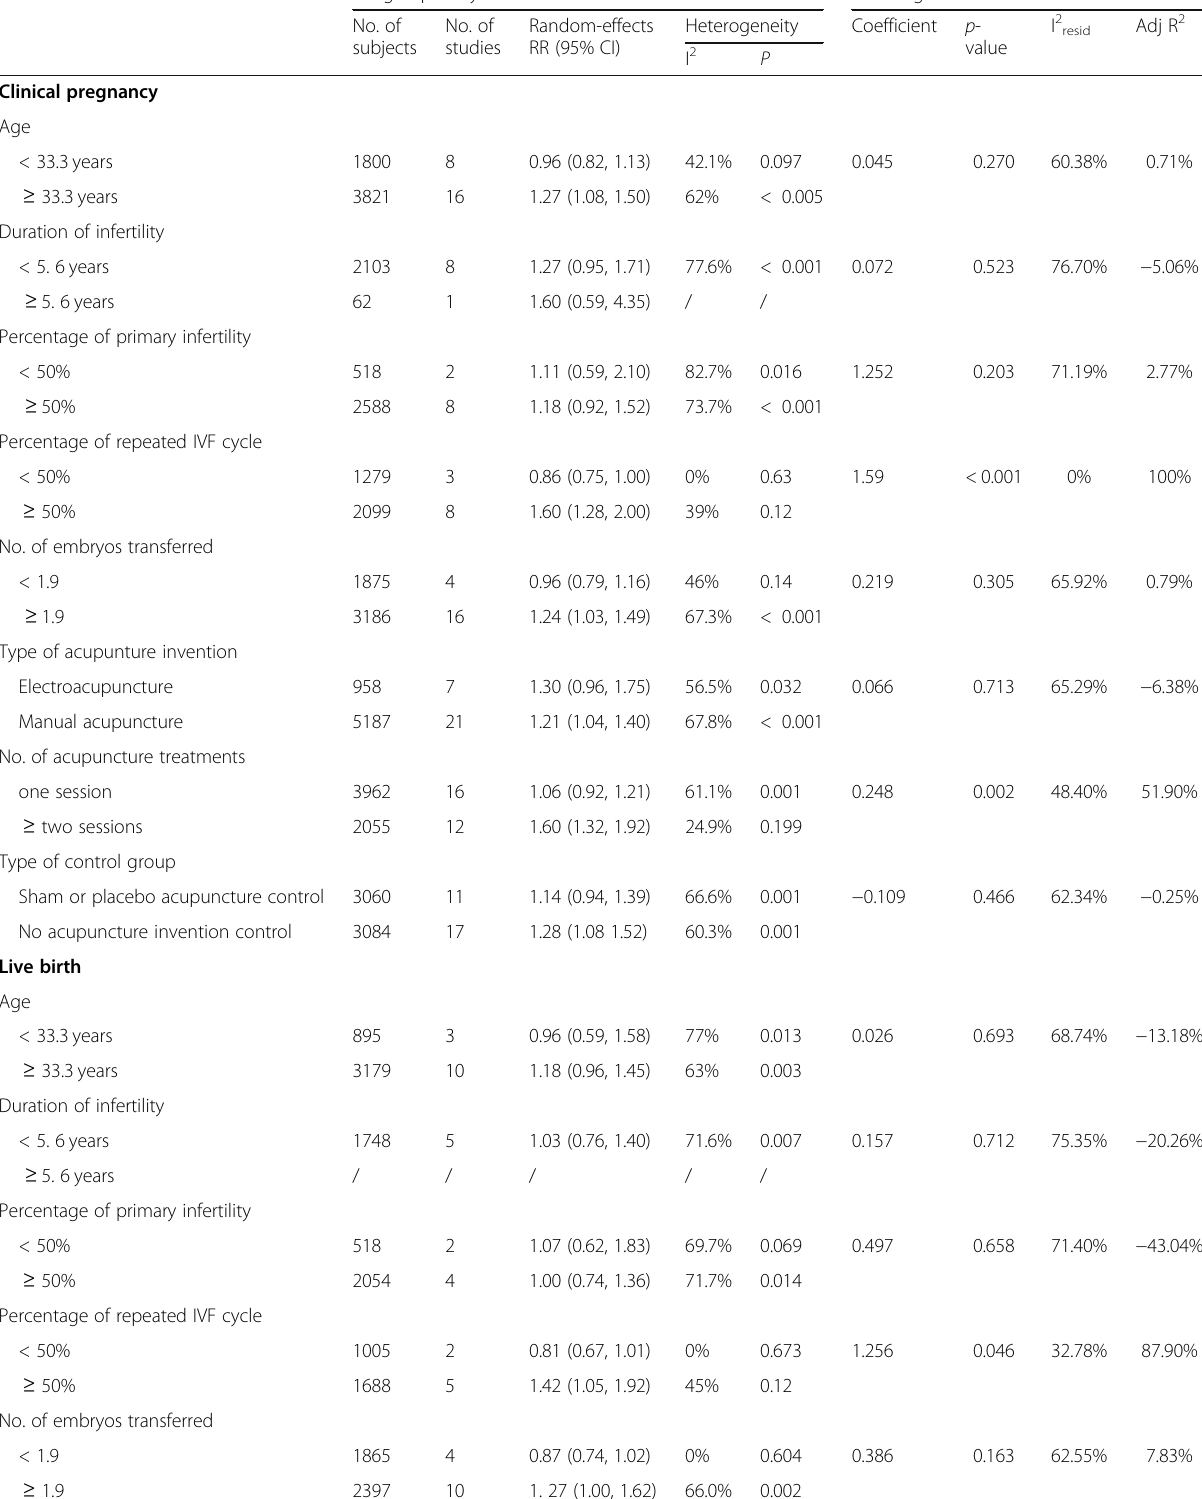
Table 3 The results of meta-regression subgroup analyses for primary